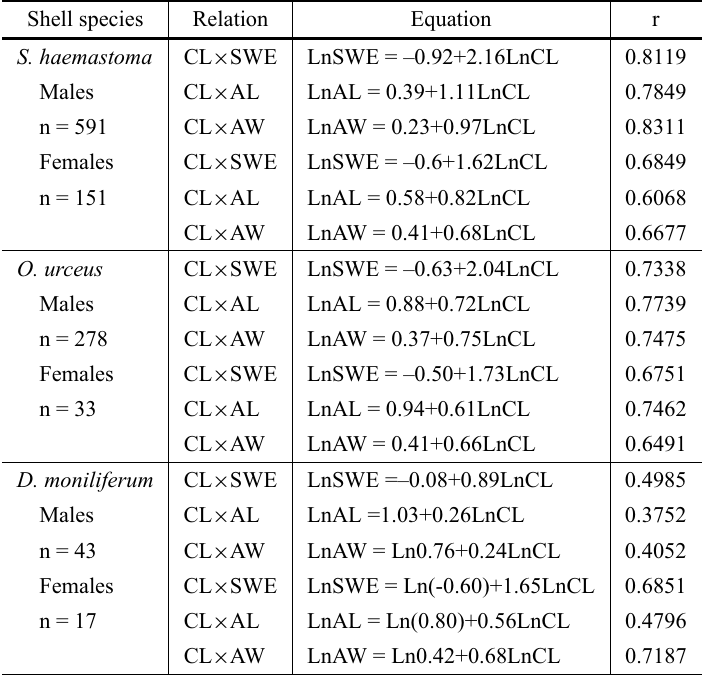
Clibanarius vittatus . Statistics for morphometric relationships (p < 0.05) between the hermit crab sexes and the three most frequently occupied shell species.